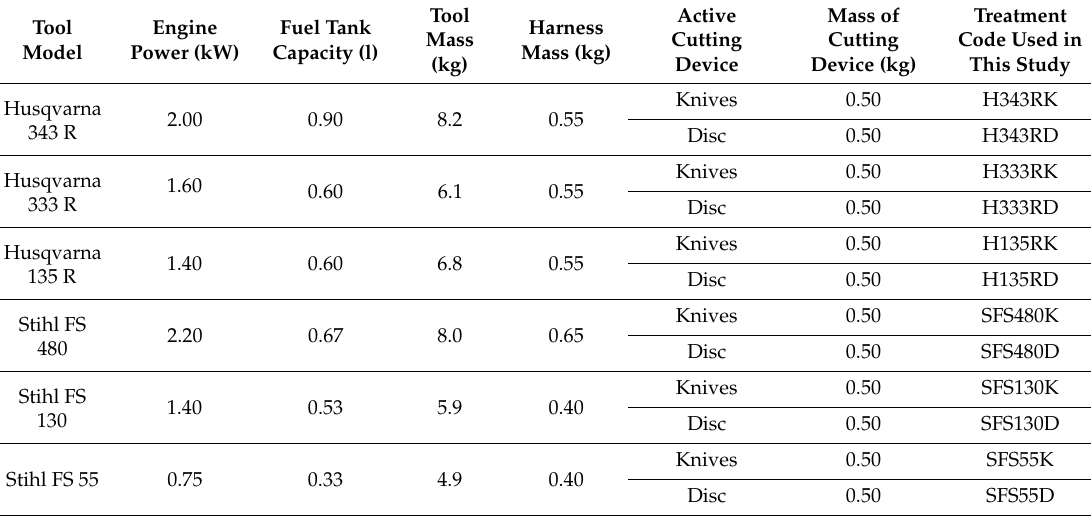
Table 1. Description of the equipment